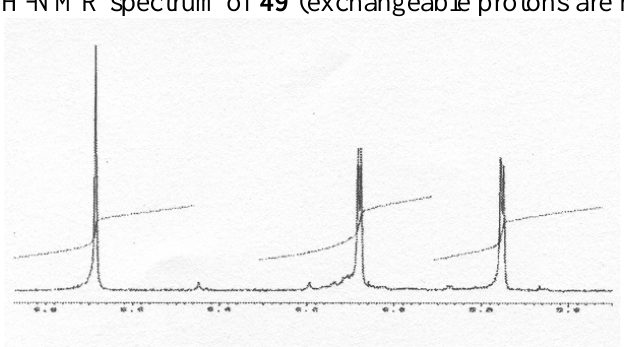
Figure 11. 1 H-NMR spectrum of 49 (exchangeable protons are not